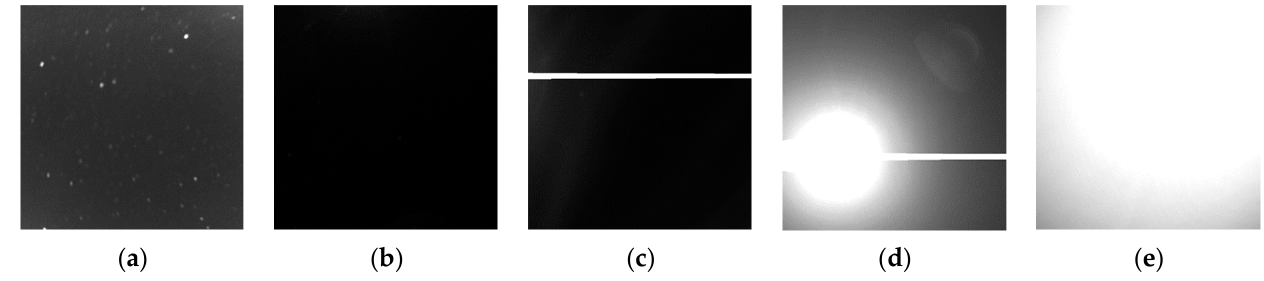
Figure 3. ( a – e ) Examples of cropped 512 × 512 images in five categories. ( a ) Clear night; ( b ) overcast sky; ( c ) light band; ( d ) moon; ( e ) twilight.